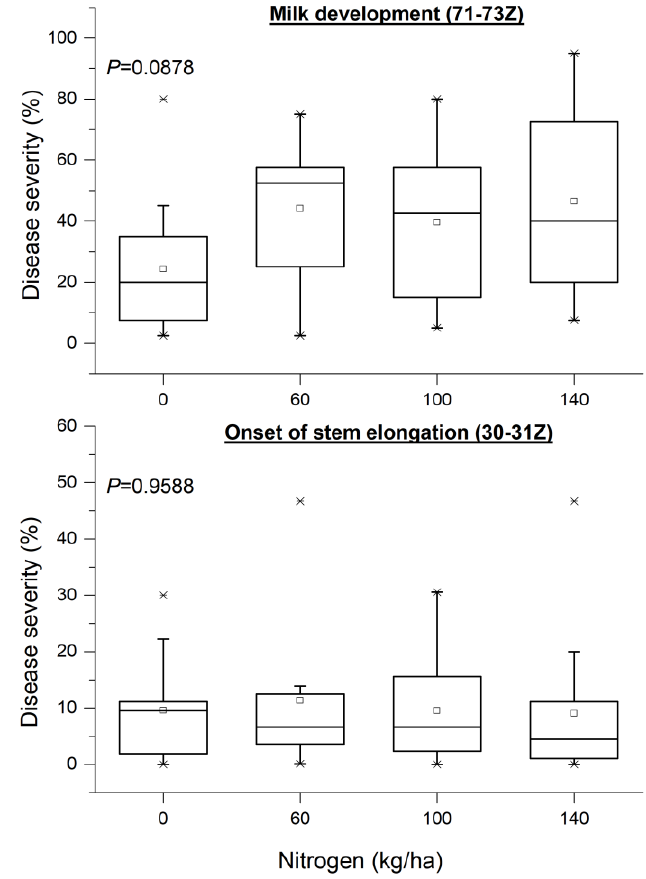
Figure 6. The effect of nitrogen rate on disease severity (caused by Pyrenophora teres f. teres and Rhynchosporium secalis ) assessed at different developmental stages of the studied malt barley varieties (Zhana, Grace, Traveler and RGT Planet). Broad lines are medians, square open dots are means, boxes show the interquartile ranges, and whiskers extend to the last data points within 1.5 times the interquartile ranges. p -values of ANOVA and permutation tests are given.